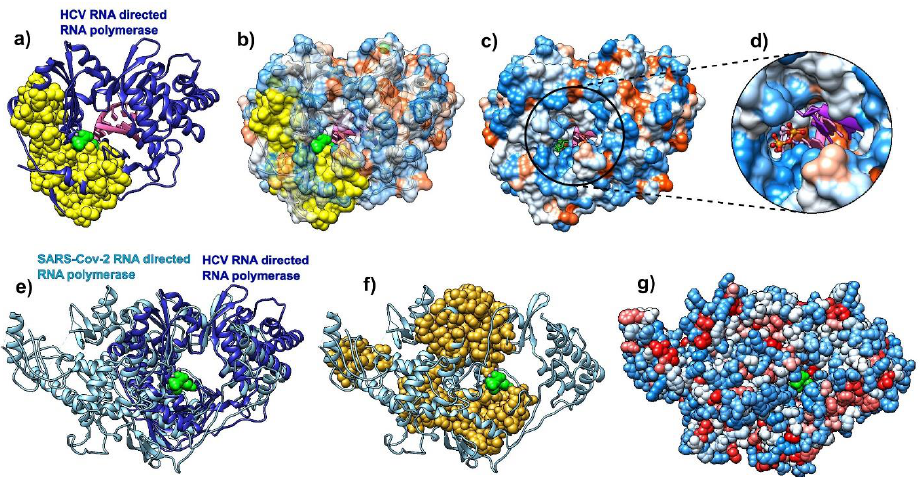
Figure 4. Comparative analysis of hepatitis C virus (HCV) (pdb id 4wtg, chain A, left) bound to sofosbuvir, and COVID-19 RNA directed RNA polymerase (RdRp, pdb id 6m71, chain A, right). ( a ) HCV RNA-directed RNA polymerase is depicted as a blue ribbon, RNA is purple, and sofosbuvir is a green molecule (full atom representation). ( b ) HCV RdRp is represented as a transparent hydrophobic surface, SAGNM predictions are yellow and sofosbuvir is represented via green atoms. ( c ) HCV RdRp is represented as an opaque hydrophobic surface, and sofosbuvir is represented via green sticks. ( d ) The inset shows sofosbuvir inside the polymerase catalytic core. ( e ) HCV RdRp (blue ribbon) structurally aligned with COVID-19 RdRp (light blue ribbon). Sofosbuvir is a green molecule inside the HCV RdRp catalytic core. ( f ) COVID-19 RdRp as a light blue ribbon. SAGNM predictions are dark yellow atoms. Sofosbuvir is a green molecule inside the catalytic core. The position stems from the structurally aligned HCV RdRp. ( g ) COVID-19 RdRp as hydrophobically colored atoms (residues hydrophobicities). Sofosbuvir is a green molecule inside the catalytic core. The position stems from the structurally aligned HCV RdRp. With COVID-19 RNA polymerase, sofosbuvir’s position corresponds to the position it has when bound to HCV RNA polymerase.